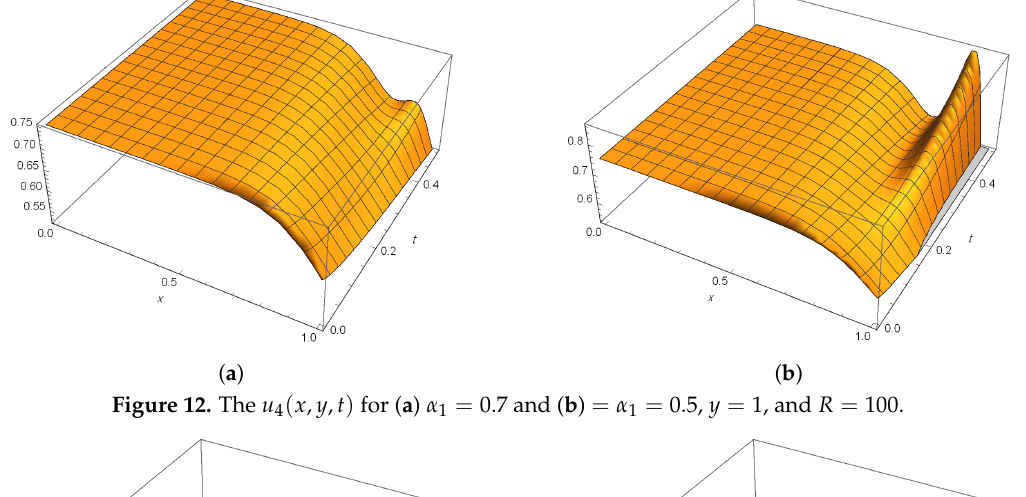
Figure 12. The u 4 ( x , y , t ) for ( a ) α 1 = 0.7 and ( b ) = α 1 = 0.5, y = 1, and R = 100.